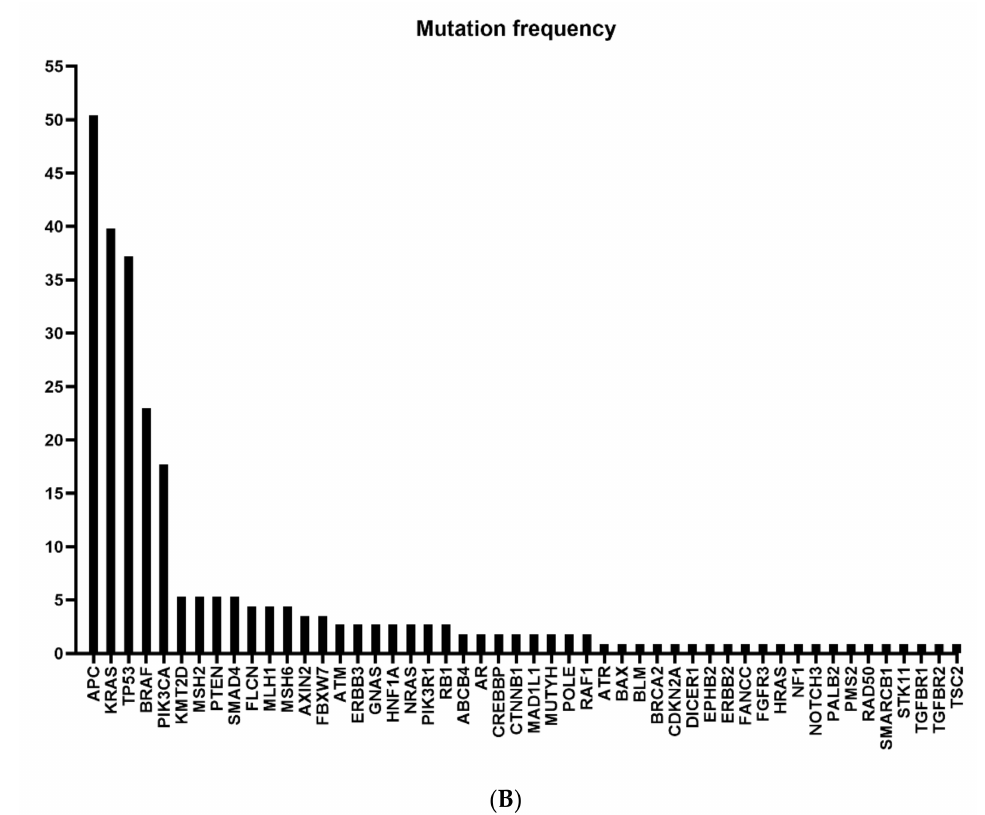
Figure 3. ( A ) = heat map. ( B ) = mutation frequency; ( A ) illustrates the number of pathogenic and likely pathogenic mutations per gene and case in a heat map, and the mutation frequency for each gene calculated out of this data is illustrated in ( B